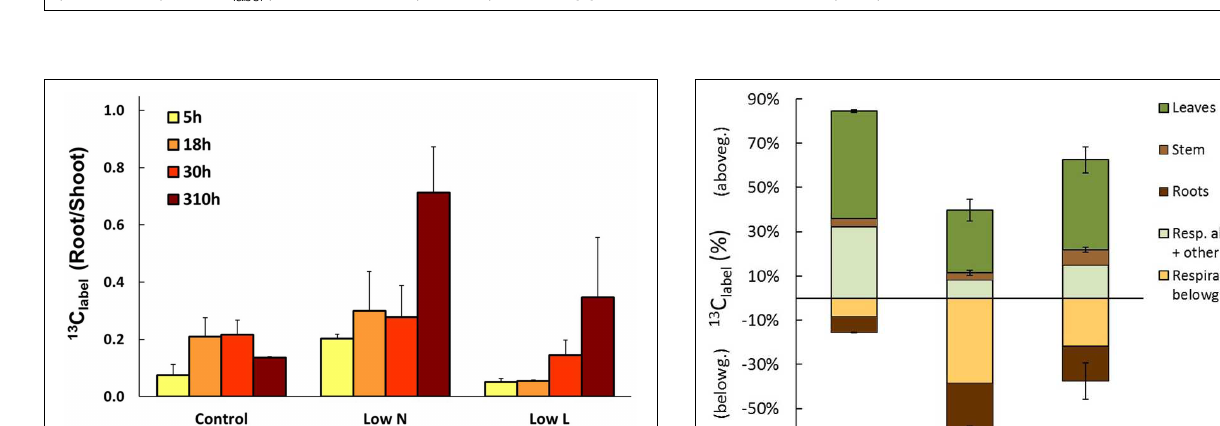
FIGURE 5 | Percentage of initially fixed 13 C from label ( 13 C label ; Equation 4) in eight tissue classes. Maximum measured 13 C label peak (hatched bars) and 13 C label present after 310h (filled bars) of control (A) ,